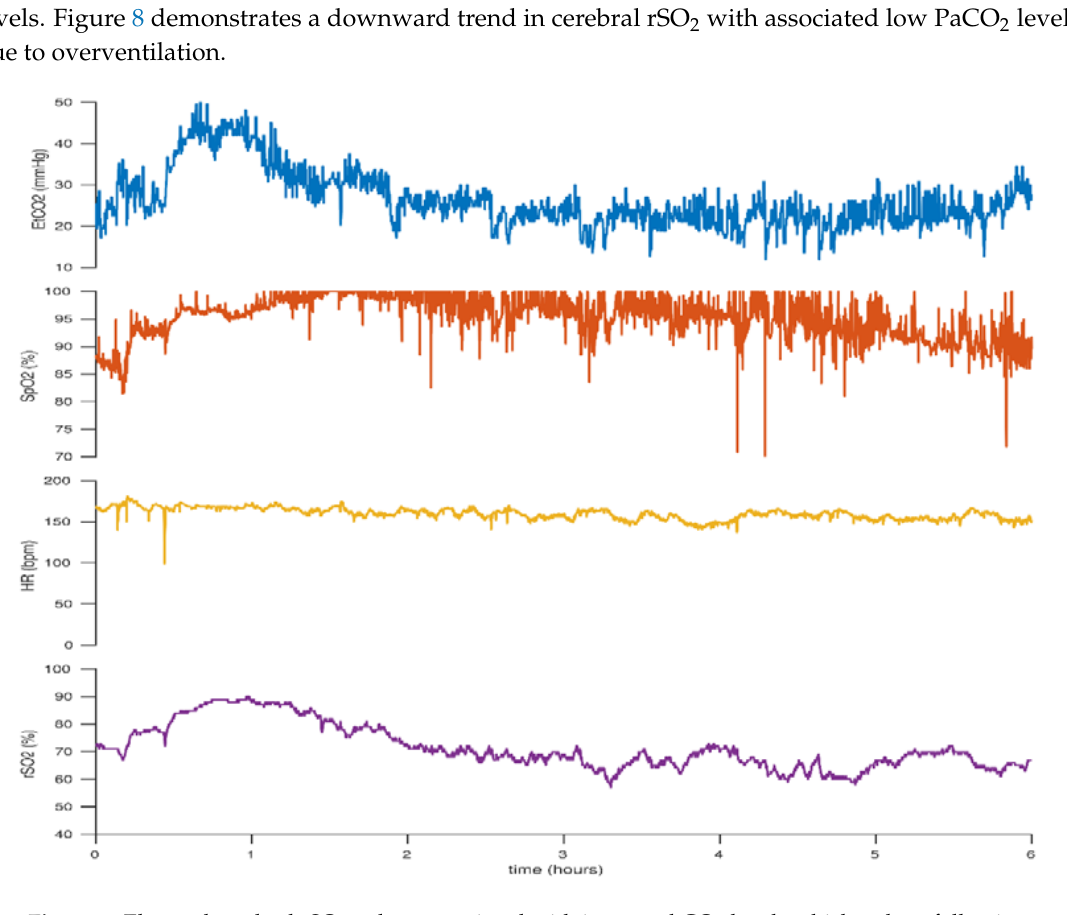
Figure 8. Elevated cerebral rSO 2 values associated with increased CO 2 levels which reduce following a decrease in CO 2 levels. This figure reflects the case of a neonate born at 25 + 2 weeks gestation. BW 830 g, DOL 1.